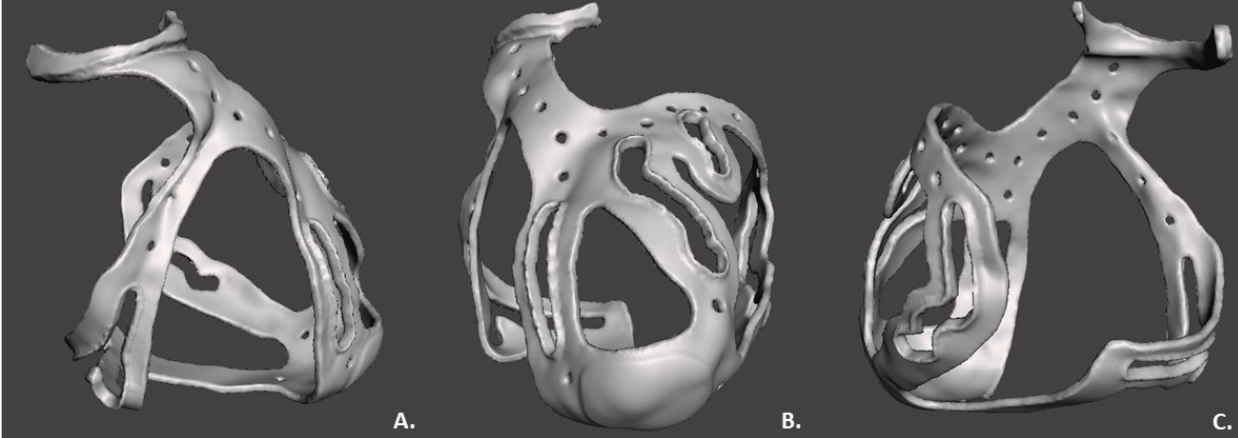
Figure 4. 3D surgical guide in three views: ( A ) Lateral view; ( B ) Frontal view; ( C ) Posterior view.